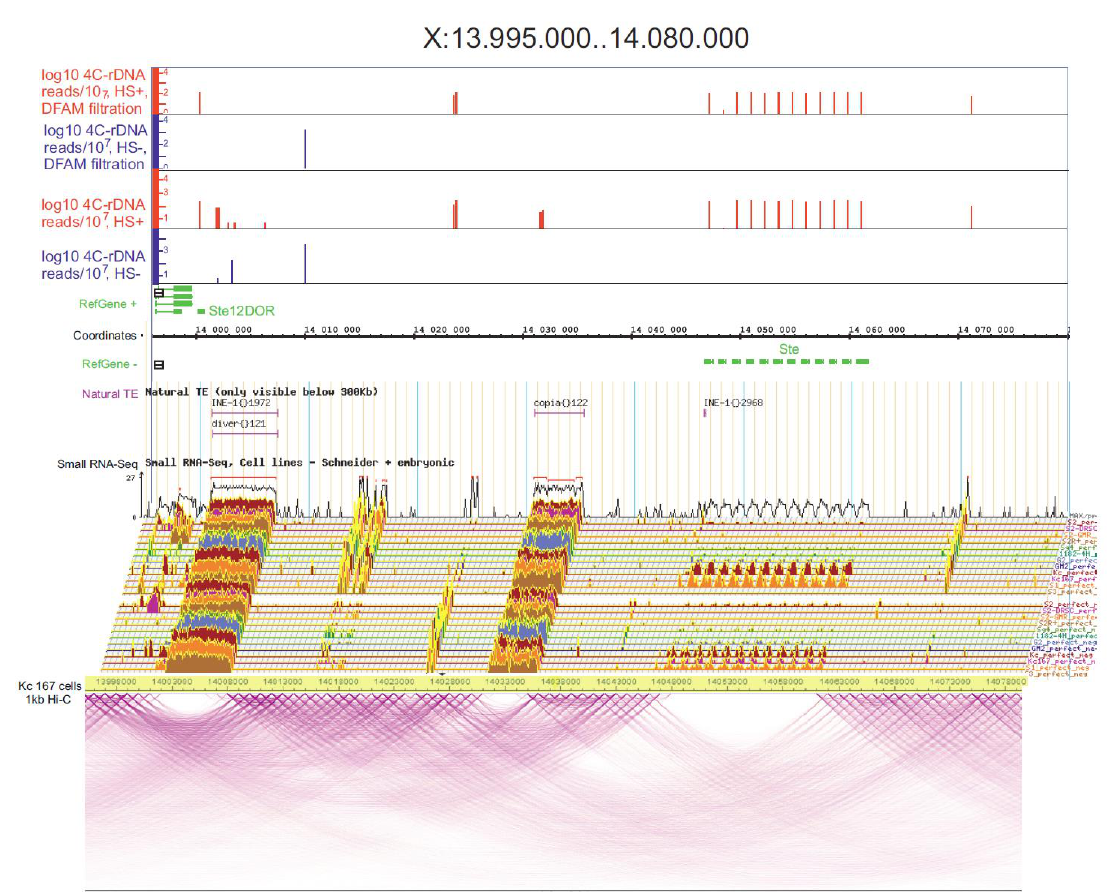
Figure 4. rDNA-contacting sites inside the Ste locus. At the top, the rDNA contacts are shown in the IGB Browser for the mapped reads without Dfam filtering and after the filtering. The contacts in Table 167. cells are shown as in the WashU EpiGenome Browser (https://epgg-test.wustl.edu/browser/).